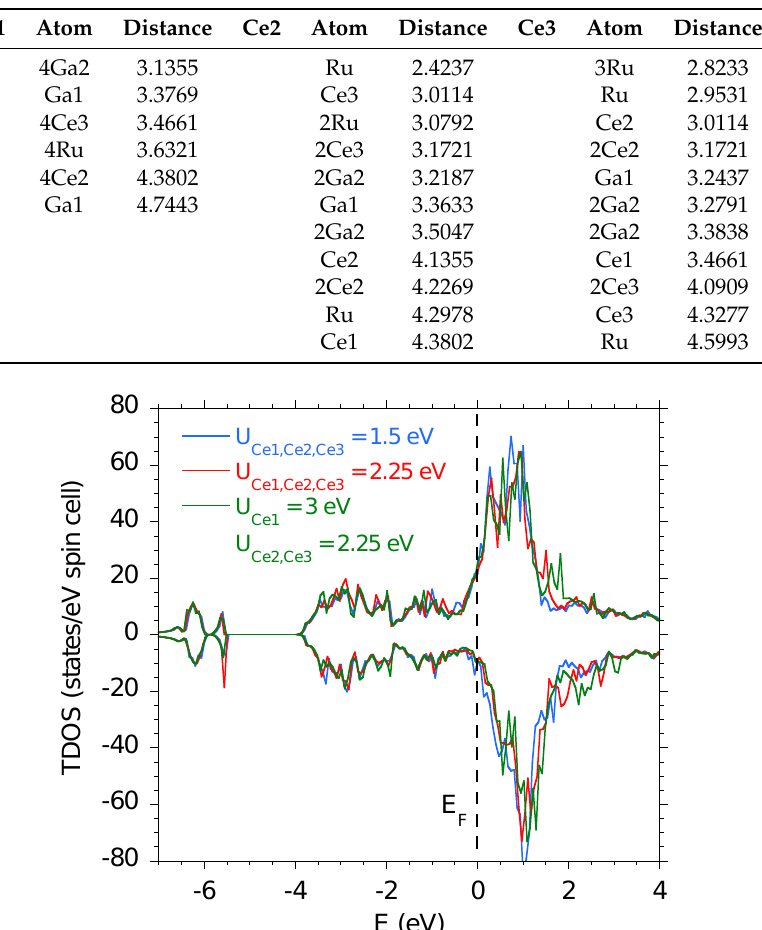
Figure 3. Total spin-resolved density of states in Ce 9 Ru 4 Ga 5 calculated for different correlation energy parameter U